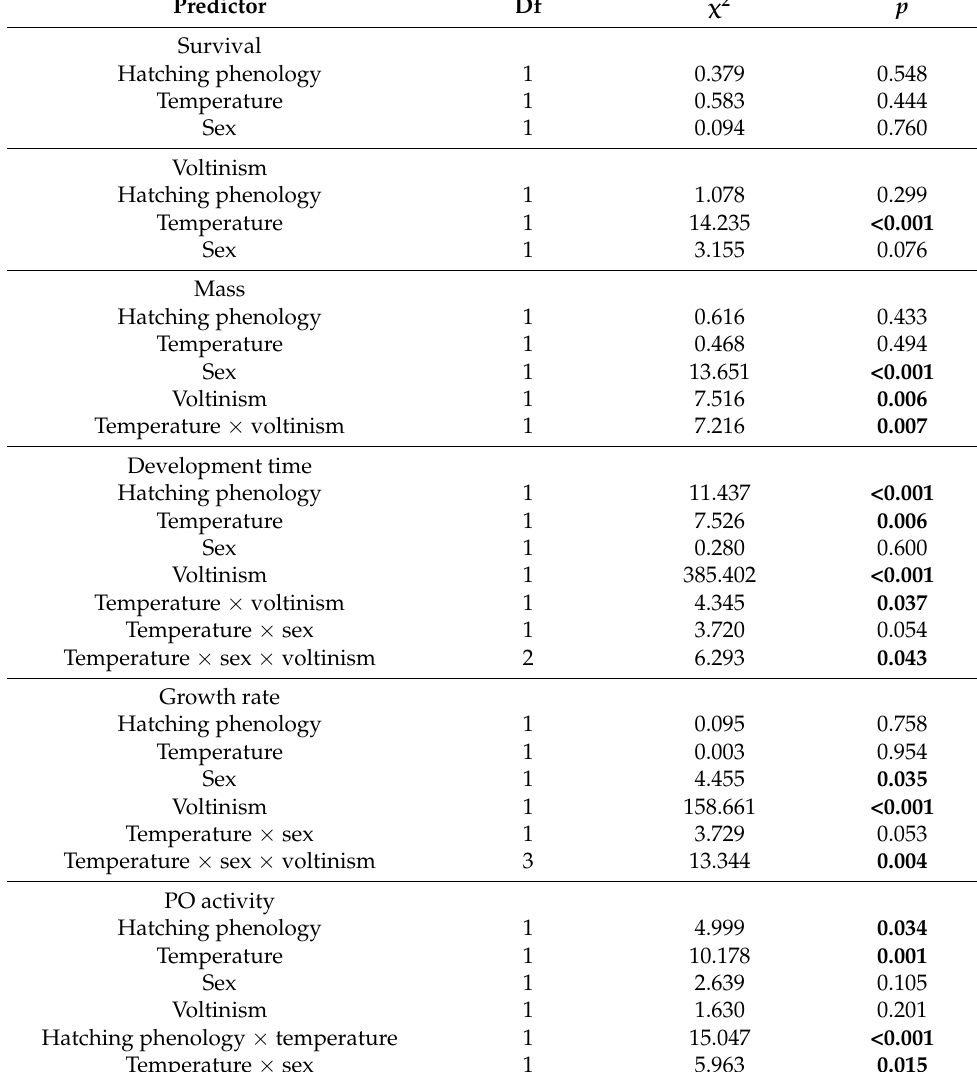
Table 1. Results from mixed models testing for effects of hatching phenology, temperature, sex and voltinism on Ischnura elegans survival, voltinism, mass, development time, growth rate and phenoloxidase (PO) activity across emerged adults. Voltinism was analyzed as a response variable and as one of the explanatory factors when analyzing other traits. Note that the voltinism effect was excluded from the survival analysis because survival was estimated at the emergence only, and not between growth seasons. Final models included all fixed effects and interaction terms with p -values ≤ 0.05. p -values below 0.05 are in